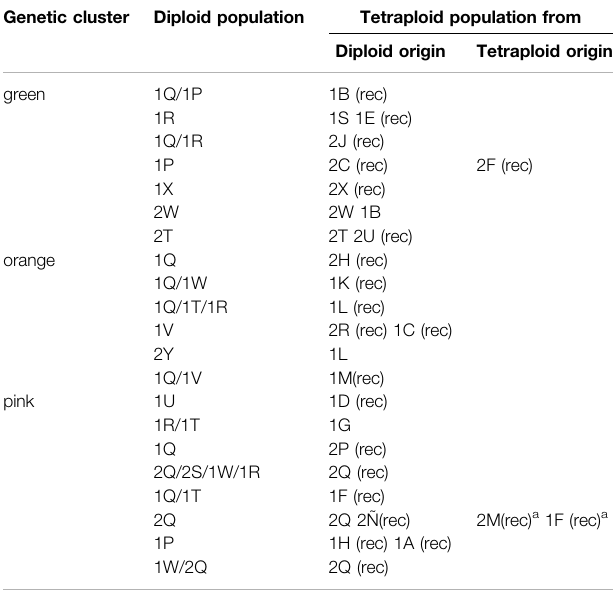
TABLE 3| PopulationorigininferredfromBayesiananalysisandNeighbor-Joining tree based on genetic distance. Genetic cluster Diploid